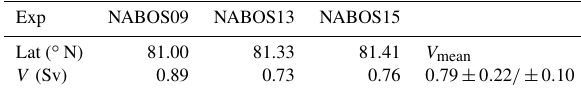
Table 2. Geostrophic estimates of the volume flow rate for near- bottom gravity flow of the Barents Sea branch of Atlantic water (BSBW) on zonal transects across the St. Anna Trough. The uncer- tainty estimates are 95% and 80% confidence intervals.